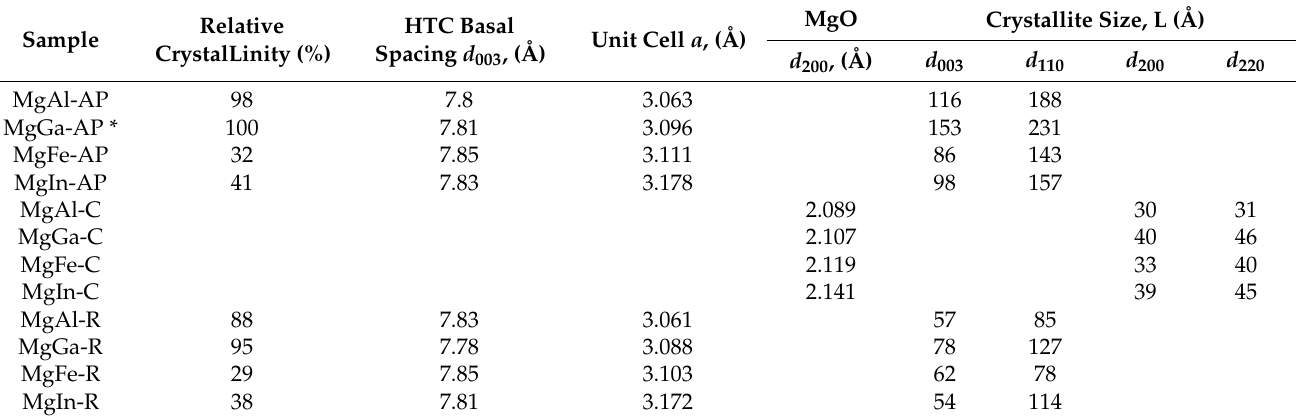
Table 2. Crystallinity, lattice parameters, and crystallite size (L(Å)) of the prepared samples.